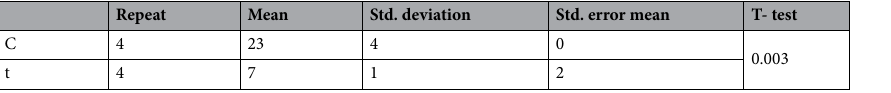
Table 2. Statistical analysis of transiently expressed pFGC-TEF-d on necrosis spot caused by N. parvum in strawberry (Camarosa cultivar) using T-